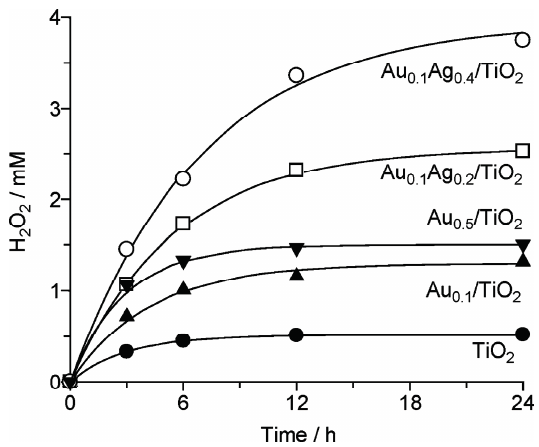
Figure 21. Build-up of photostationary levels of H 2 O 2 on Au-Ag/TiO 2 catalysts (5 mg) in 5 mL aerated 4% aqueous ethanol ( λ > 280 nm, I uv ≈ 14 mW)). (Reproduced from [259]. Copyright (2012) American Chemical